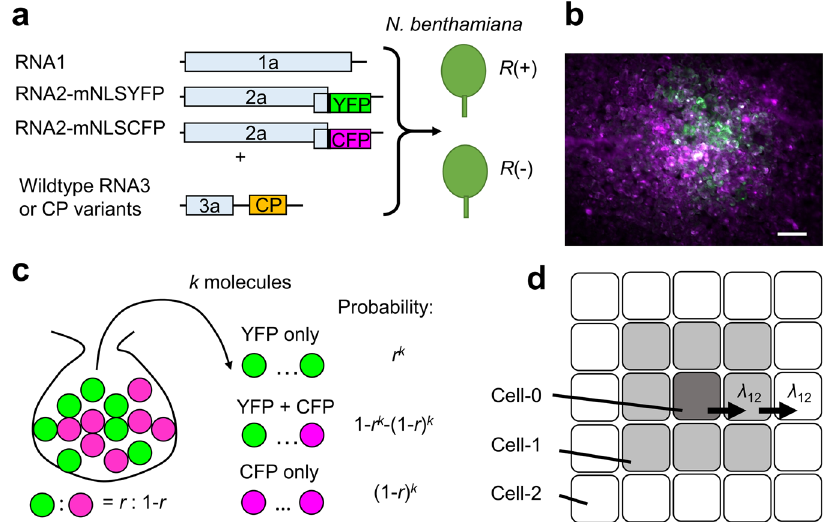
Fig. 4 Multiplicity of infection (MOI) estimation in the presence and absence of the R gene. a Schematic explanation of the inoculation procedures. b An example of stochastic separation of the two RNA2 variants at 20 h after inoculation to N. benthamiana ( R – ). YFP and CFP images were pseudocolored with green and magenta, respectively, and then merged. Scale bar = 100 μ m. c Idea for MOI estimation: if a number of balls are randomly selected from a mixture of two types of balls, the probability that either of the two types is selected increases as the number of balls selected decreases. d Classi fi cation of infected cells by the number of cell-to-cell movements experienced by intracellular viral populations. MOIs for fi rst and second cell-to-cell movements were assumed to be equal ( = λ 12 ) in the current experiments.